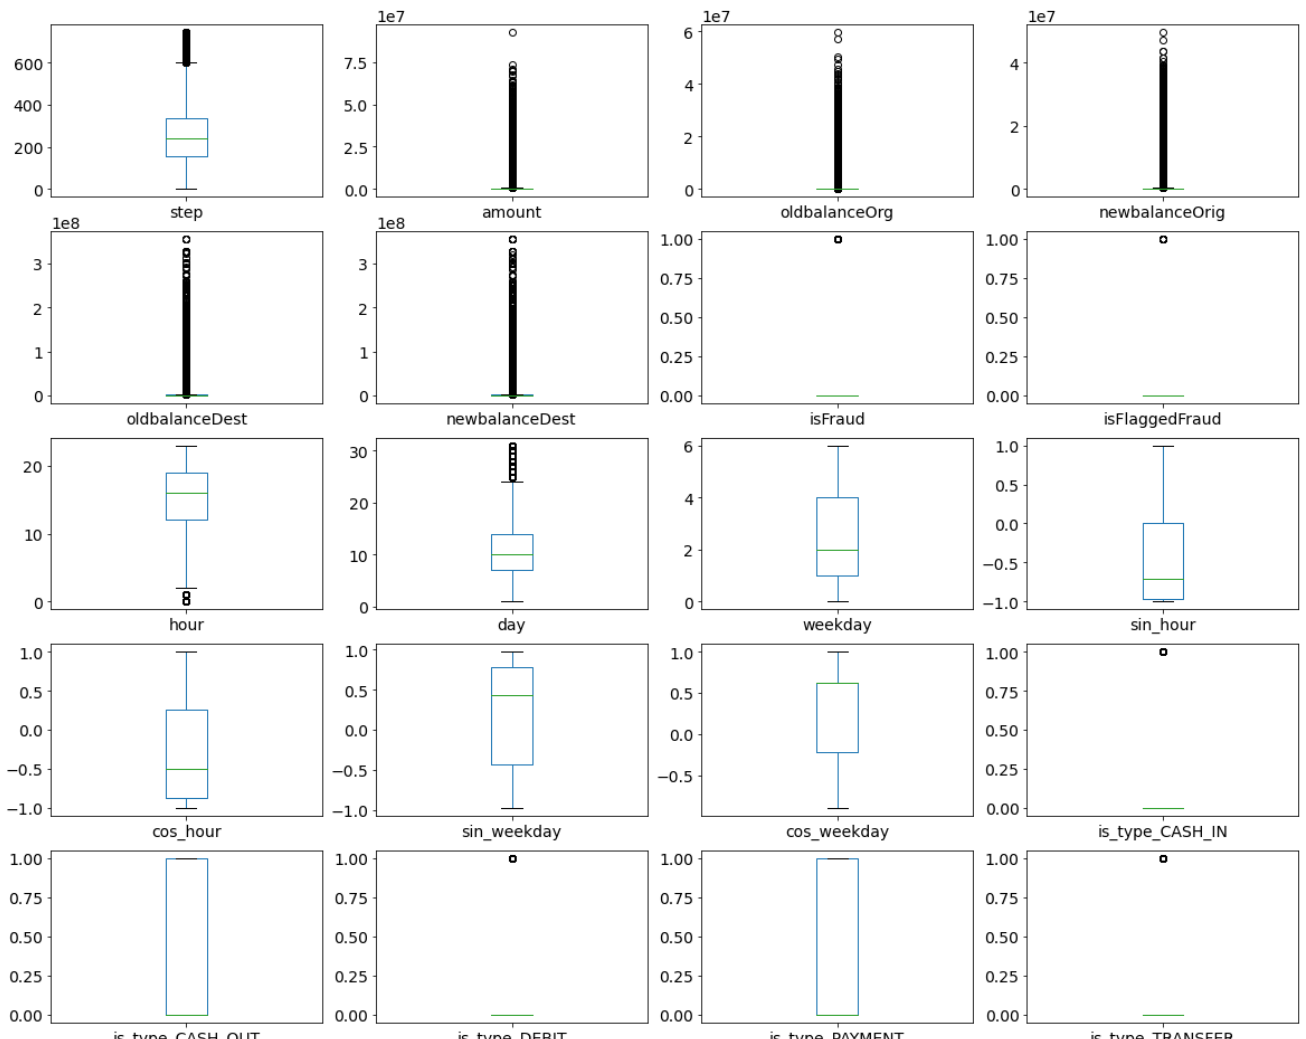
Figure 7. Extended PaySim dataset box plots.